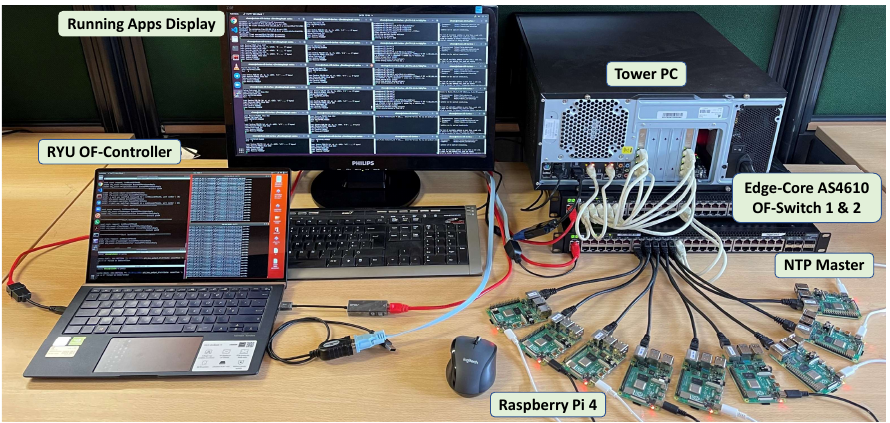
Figure 12. View of the complete experimental